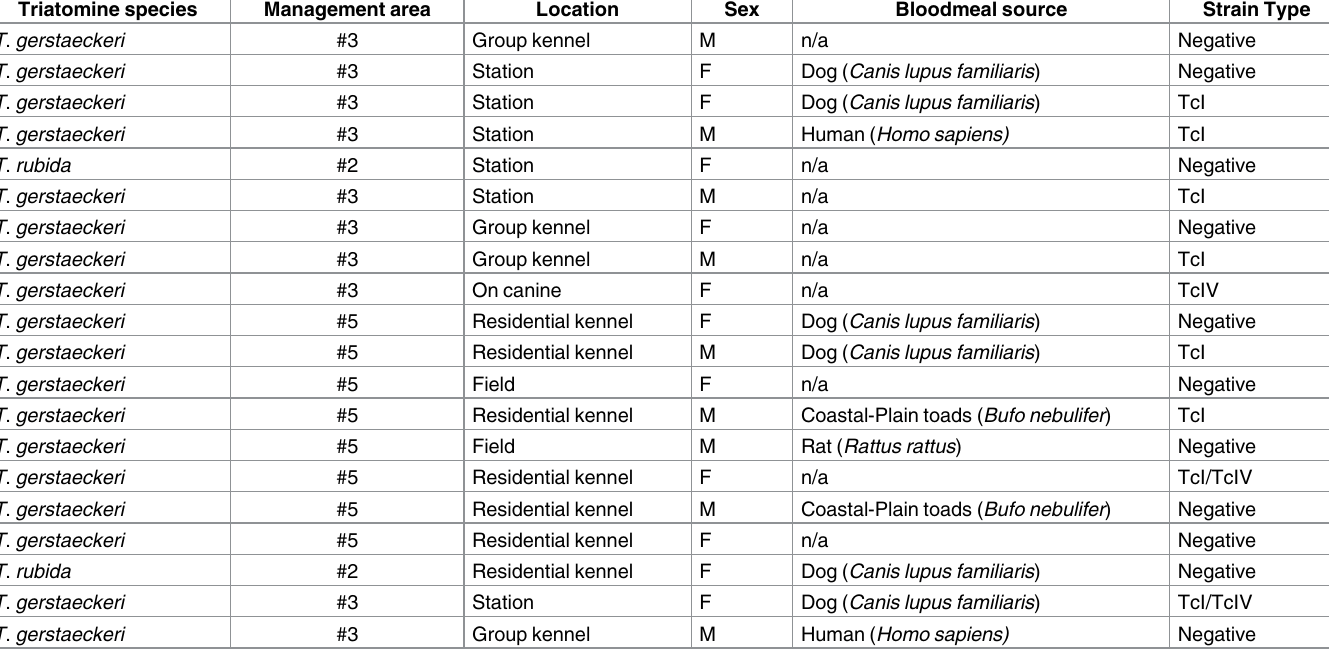
Table 6. Triatoma spp. collected from locations where canines sleep or work were tested for Trypanosoma cruzi presence, strain type of T . cruzi and bloodmeal source were determined. Triatomine